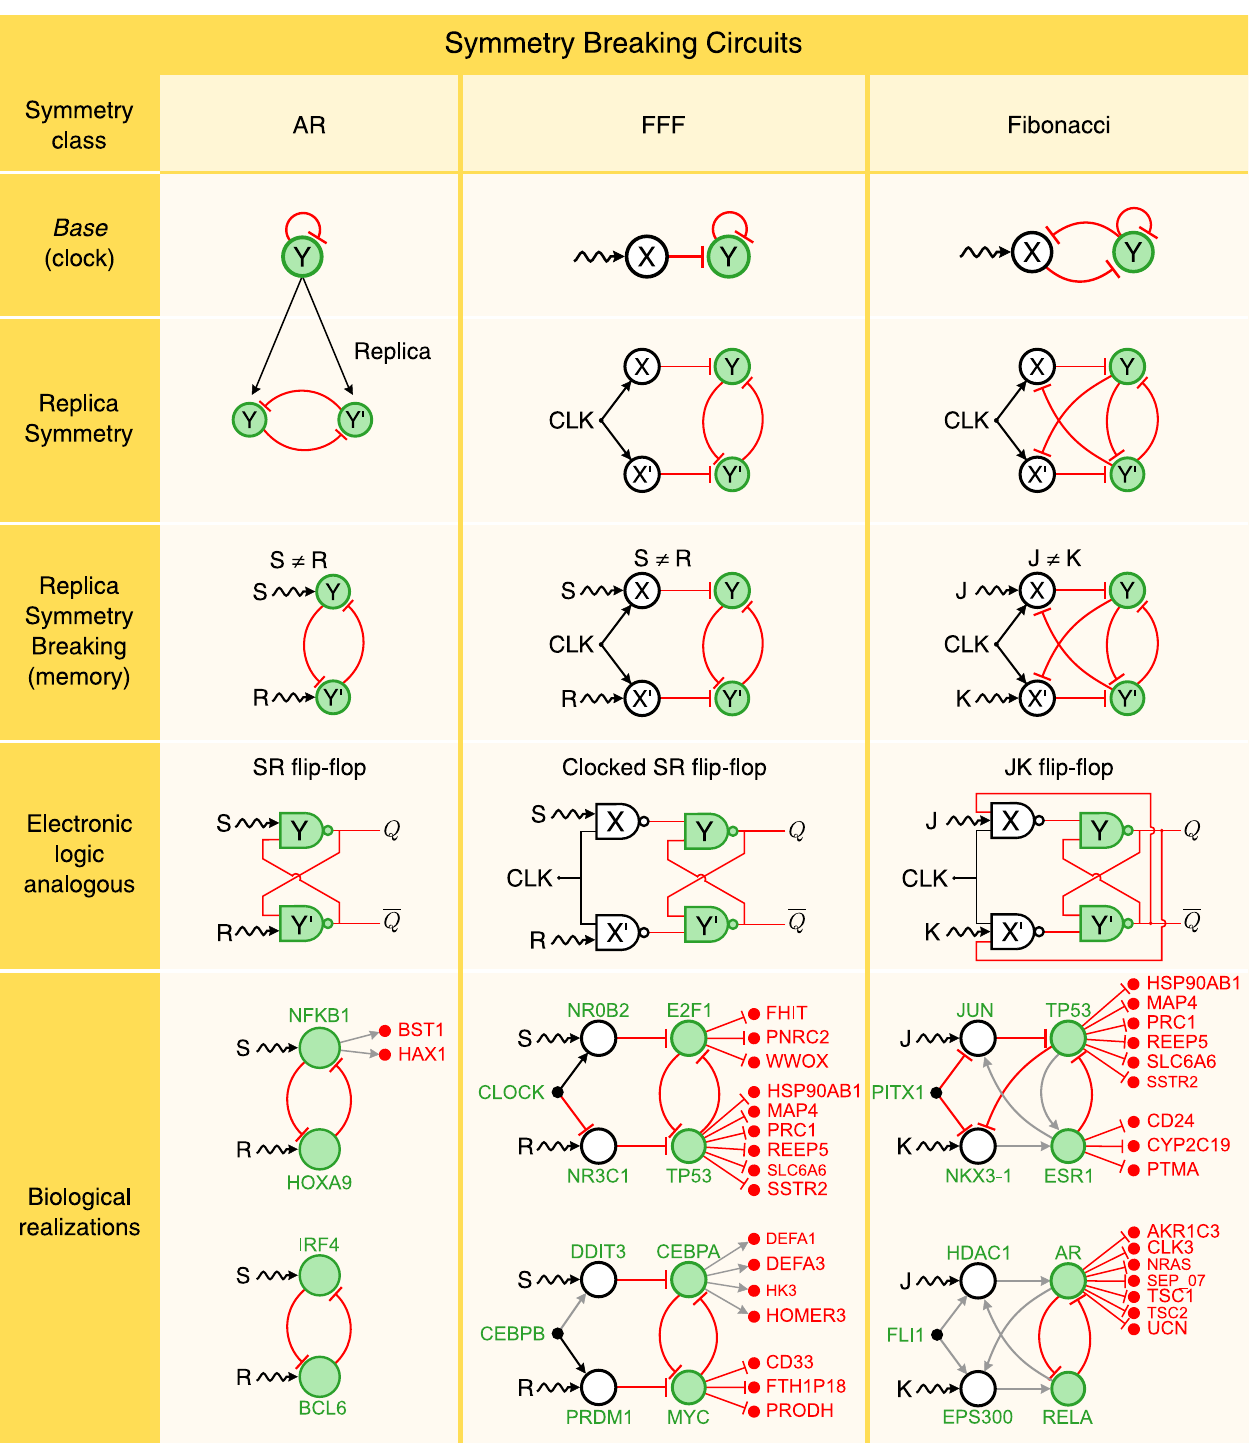
Fig 4. Broken symmetry circuits function as memory. AR (first column) : The replica symmetry duplication of the AR symmetric circuit results in a network that is analogous to the SR flip-flop circuit. The symmetry between Y and Y’ is broken by the inputs S and R, such that S 6¼ R, resulting into a pair logical outputs Q and � Q ¼ not ð Q Þ . FFF (second column) : Following the same strategy, we replicate the FFF through a replica symmetry duplication. Note that this operation adds a second level of logic gates to the SR flip-flop. In order to have consistent logic operations, we add an input clock gene CLK in addition to S and R. The resulting circuit is analogous to the Clocked SR flip-flop logic circuit. Fibonacci (third column : The replica symmetry duplication of